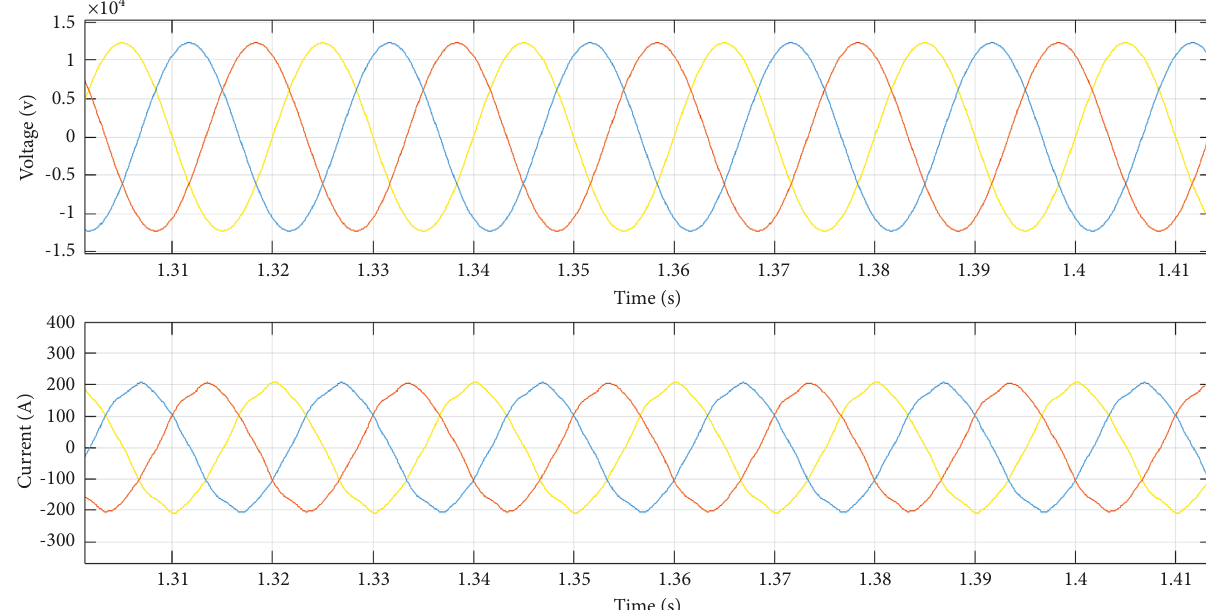
Figure 10: Grid side voltage and current wave form for PI with phase shifted